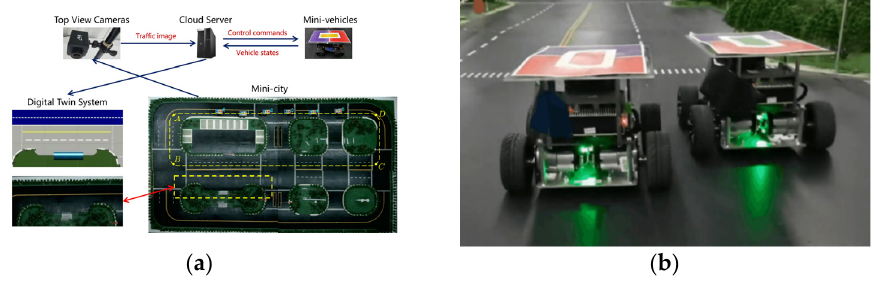
Figure 18. ( a ) An overview of the Sicity platform; ( b ) experimental electric mini ‐ vehicles.